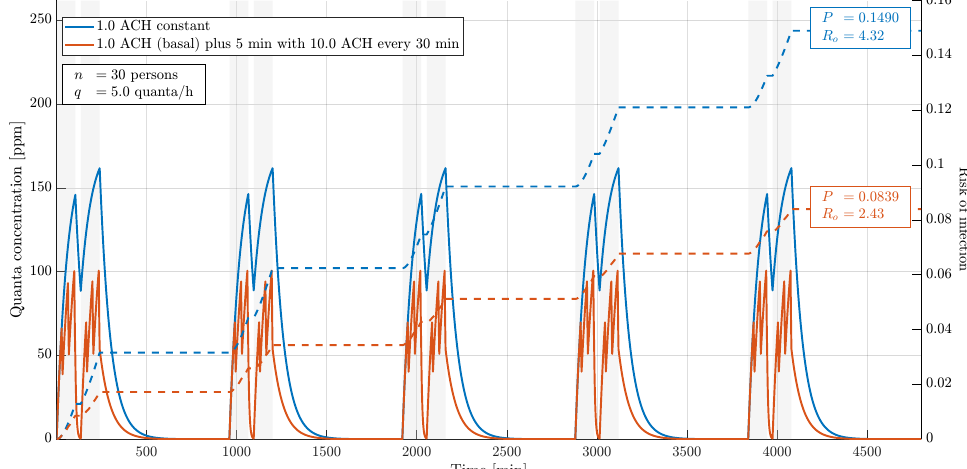
Figure 12. Comparison between static and dynamic ventilation rates, evaluated with artificial quanta concentration curves and the Gammaitoni-Nucci model. Full curves represent quanta concentrations and dashed curves represent the probability of infection. The grey shaded background identifies occupation periods. The coloured boxes detail the probability of infection and the basic reproduction number by the end of the